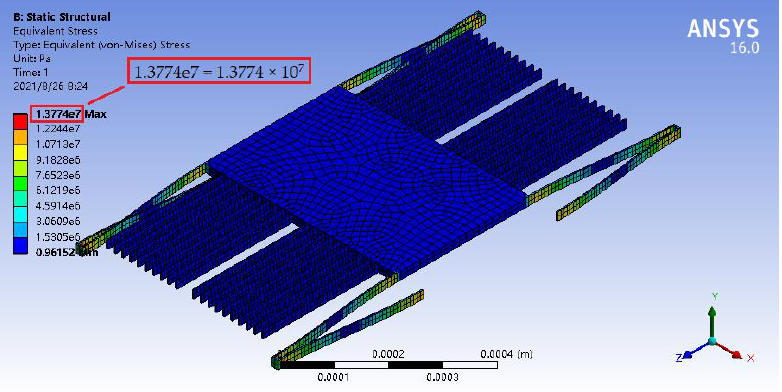
Figure 16. Stress nephogram of the micro-accelerometer under the acceleration of 100 g at 500 °C.